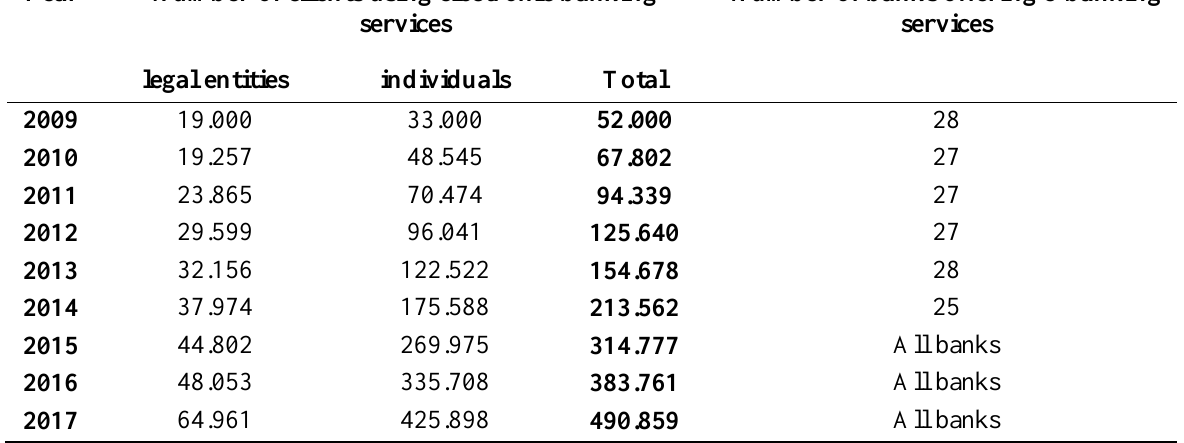
Table 1. Number of clients using electronic banking services